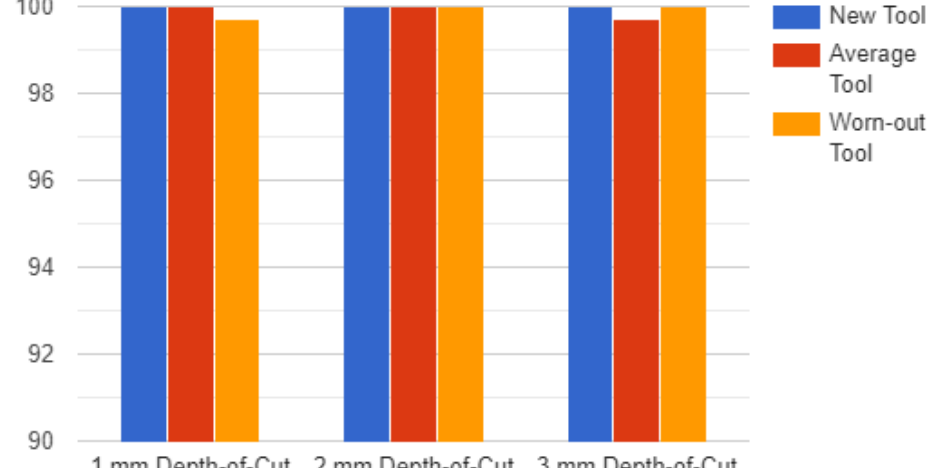
Figure 20. Accuracy Chart for Softwood.